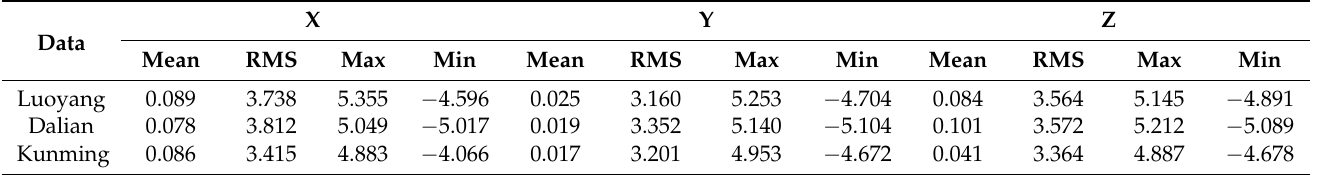
Table 15. Direct uncontrolled positioning accuracy based on calibrated alignment angles and pointing angle files. (Unit: